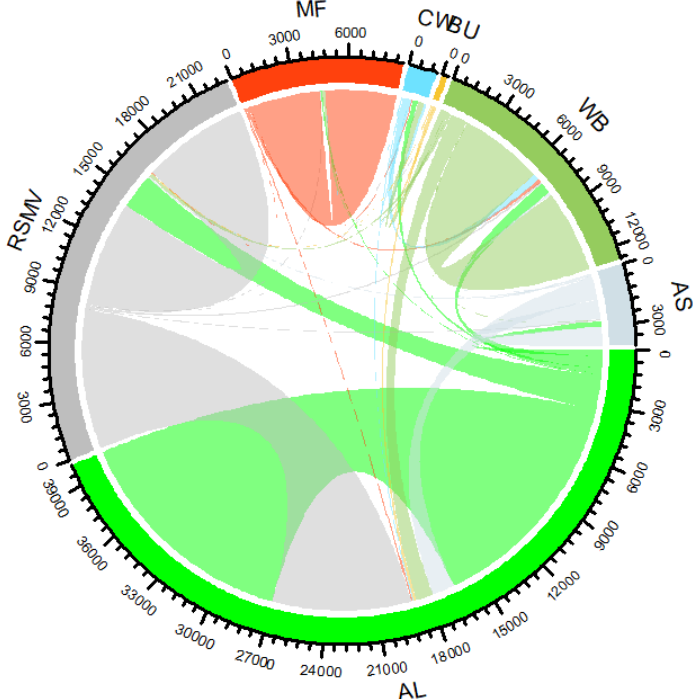
Figure 4. Chord diagram of land use transformation in CRB from 1999 to